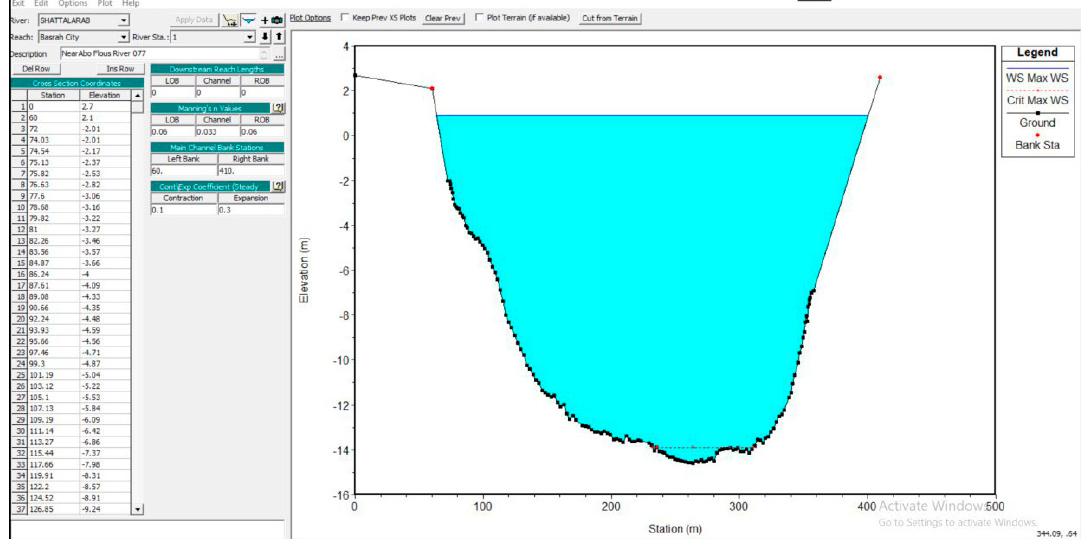
Figure 4. Cross-section data editor for cross-section no. 1.